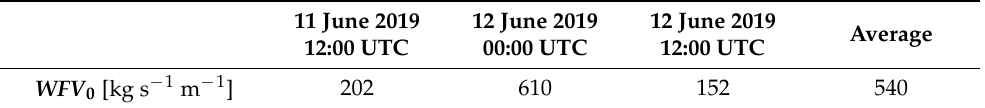
Table 3. The Water Vapour Flux ( WVF 0 ) values considered as the initial conditions for the linear upslope